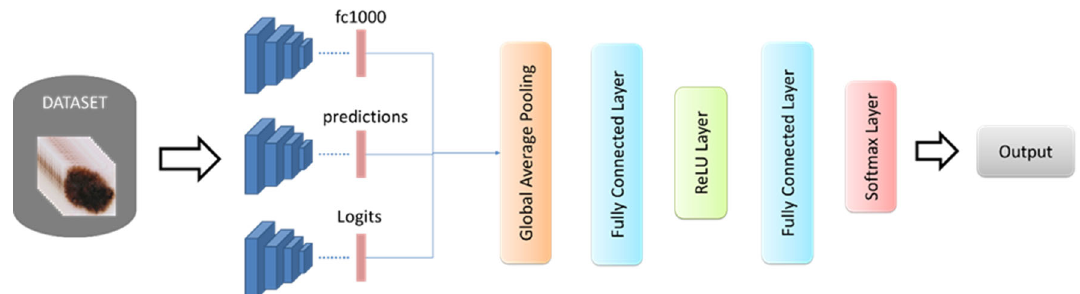
Figure 5. The structure of the proposed classifier model.